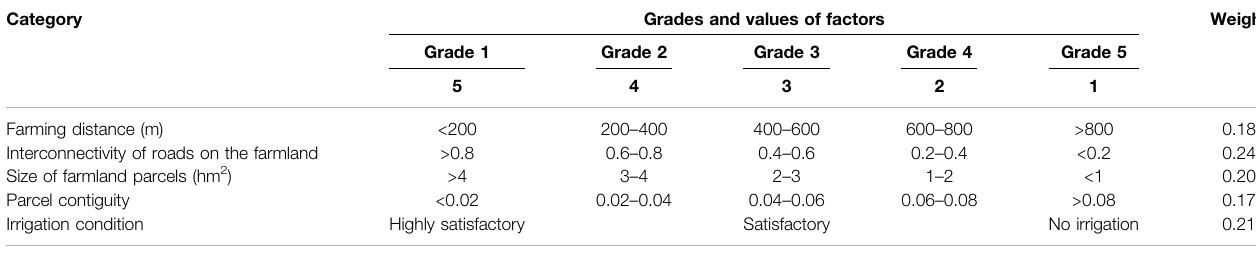
TABLE 2 | Evaluation indicators of farmland marginalization based on farming